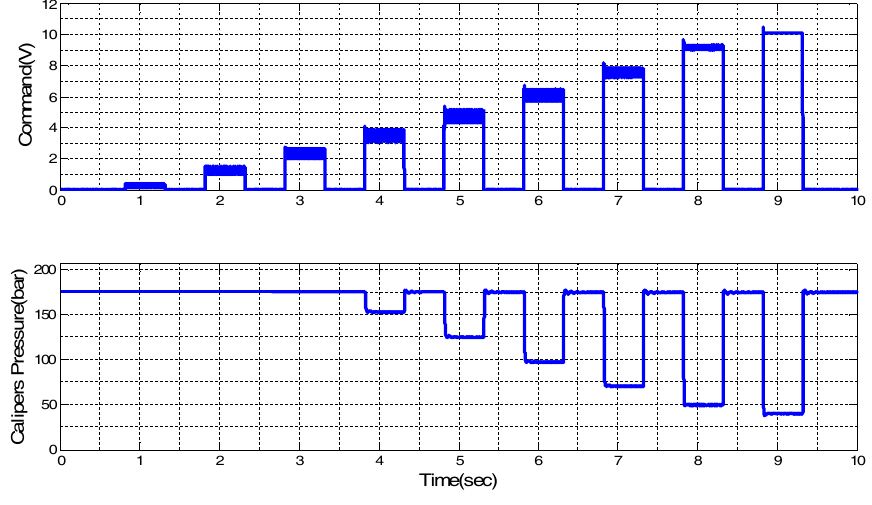
Figure 21. Step wave command at proportional valve relief test in 175 bars.